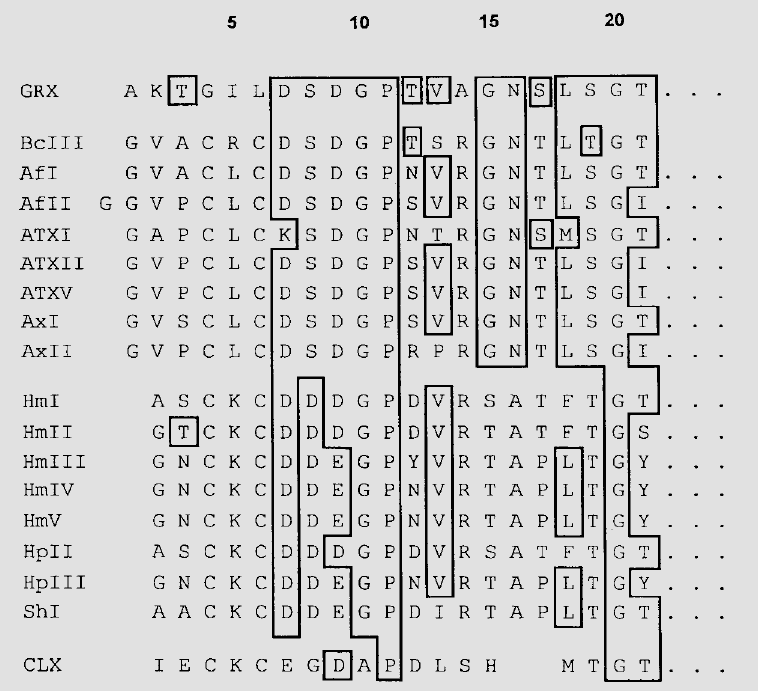
Figure 2 - Partial amino acid sequences of GRX, type 1, type 2 and type 3 long polypeptides from sea anemones. Identical residues are boxed. GRX was obtained from Bunodosoma granulifera , BcIII from Bunodosoma caissarum , AfI and AfII from Anthopleura fuscoviridis , ATXI, ATXII and ATXV from Anemonia sulcata , AxI and AxII from Anthopleura xanthogrammica , HmI, HmII, HmIII, HmIV and HmV from Radianthus macrodactylus , HpII and HpIII from Radianthus paumotensis , ShI from Stichodactyla he- lianthus , and CLX from Calliactis parasitica